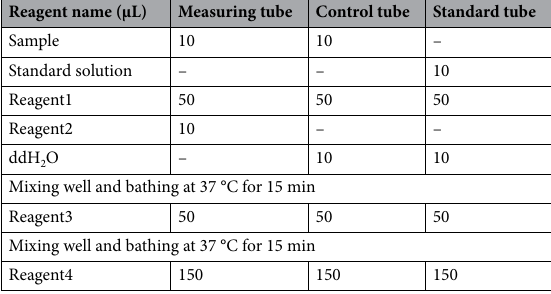
Table 4. LDH reaction system.